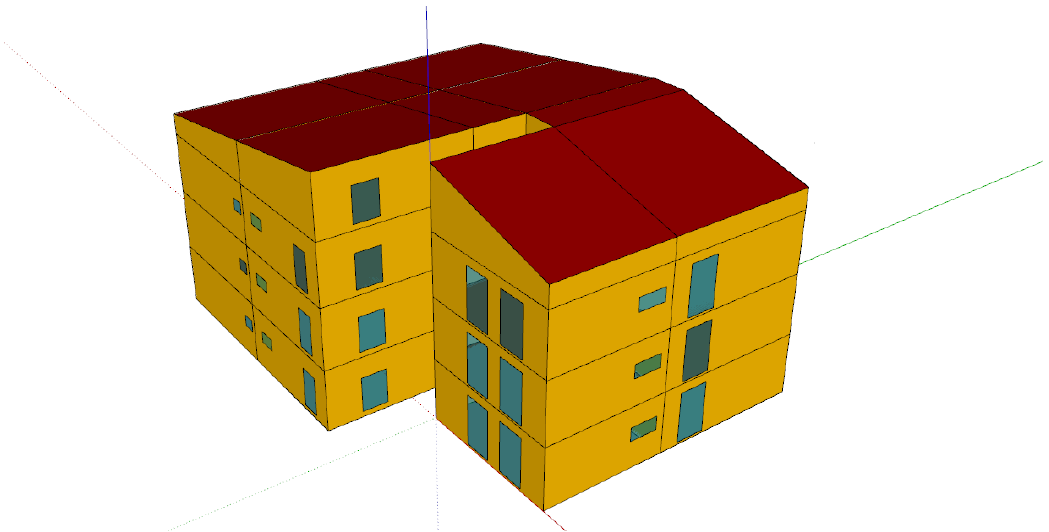
Figure 3. 3-D model of the building case-study.